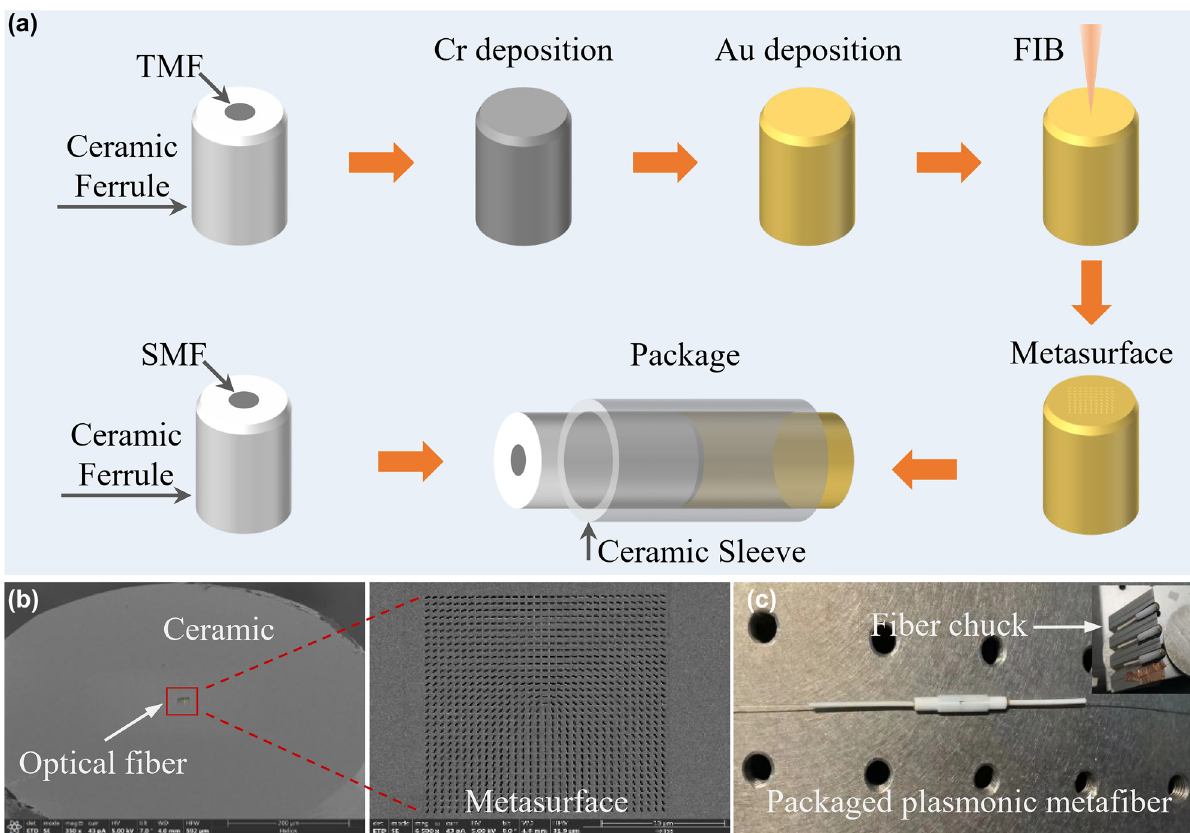
Figure 2: Fabrication and characterization of the plasmonic metafiber. (a) Fabrication of metasurface on TMF-CF using FIB lithography and package with SMF-CF using a ceramic sleeve. (b) SEM image of a fabricated metasurface. (c) Picture of a packaged metafiber and the fiber chuck.